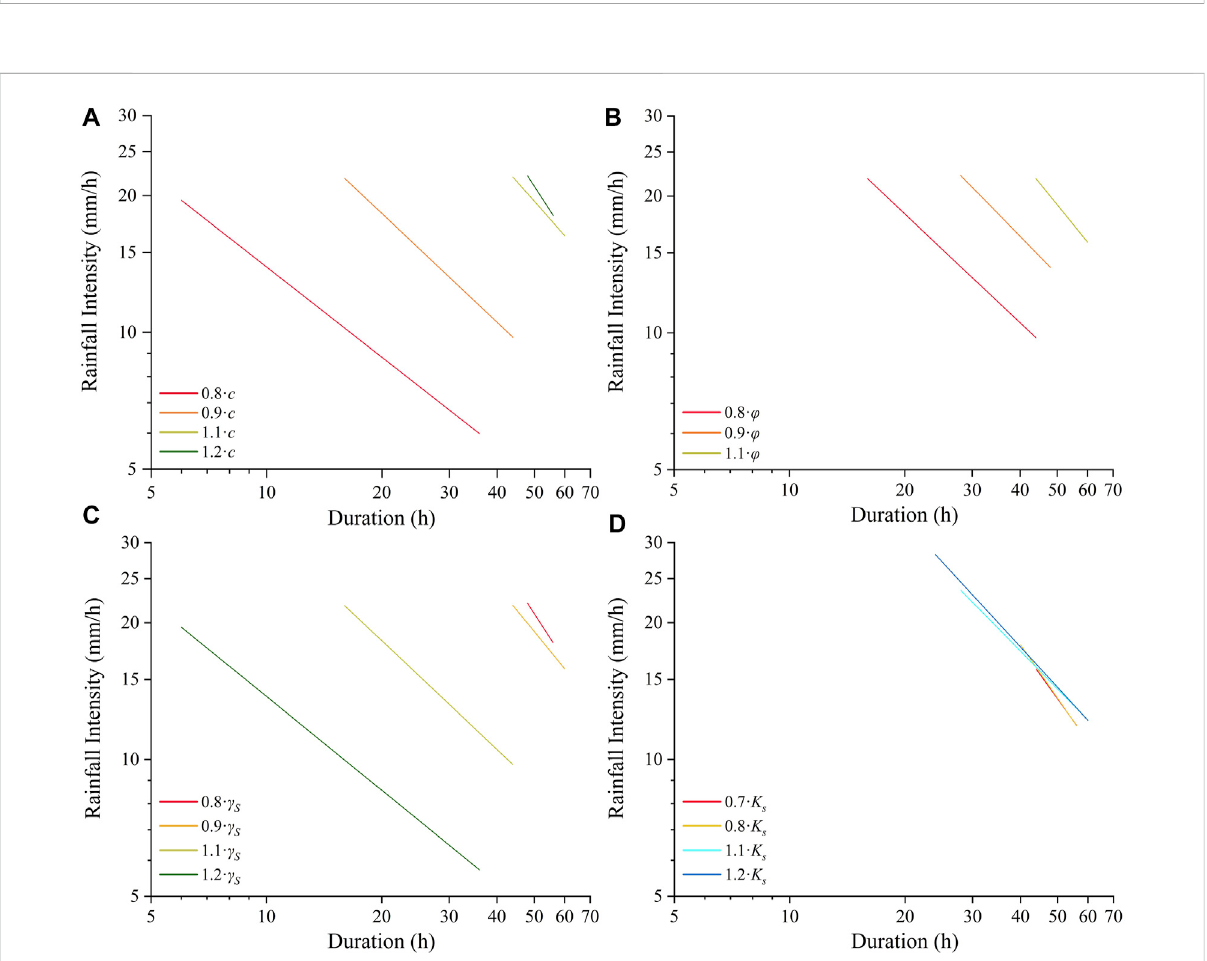
FIGURE 6 I-D thresholdsde fi nedatthebasinscaleundergivensoilmechanicalandhydraulicparameters: (A) c , (B) φ (thethresholdswerethesameunder the condition of 1.1 · φ and 1.2 · φ ), (C) γ s , and (D) K s